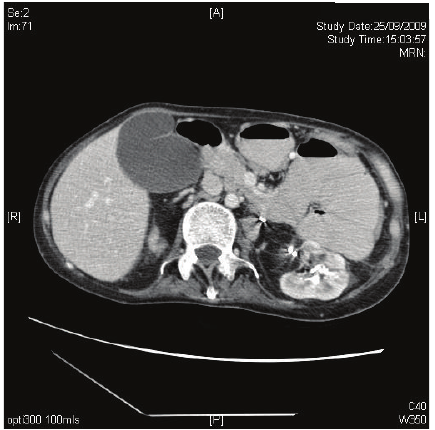
Figure 8: CT abdomen, performed on 25 September 2009, revealed loops of dilated proximal small bowel and distended gall